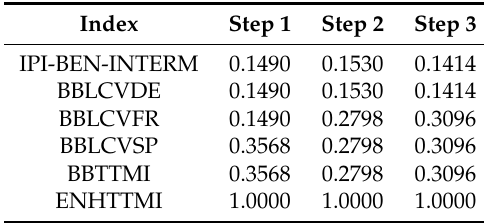
Table 8. Model confidence set hierarchy loss function is the squared error at the end of the sample for intermediate goods model comparison α = 0.05, number of bootstrap replications = 5000 and block length = 12. The null hypothesis is that the average performance of the model in the row is as small as the minimum average performance across the remaining models. The alternative is that the minimum average loss across the remaining models is smaller than the average performance of the model in the